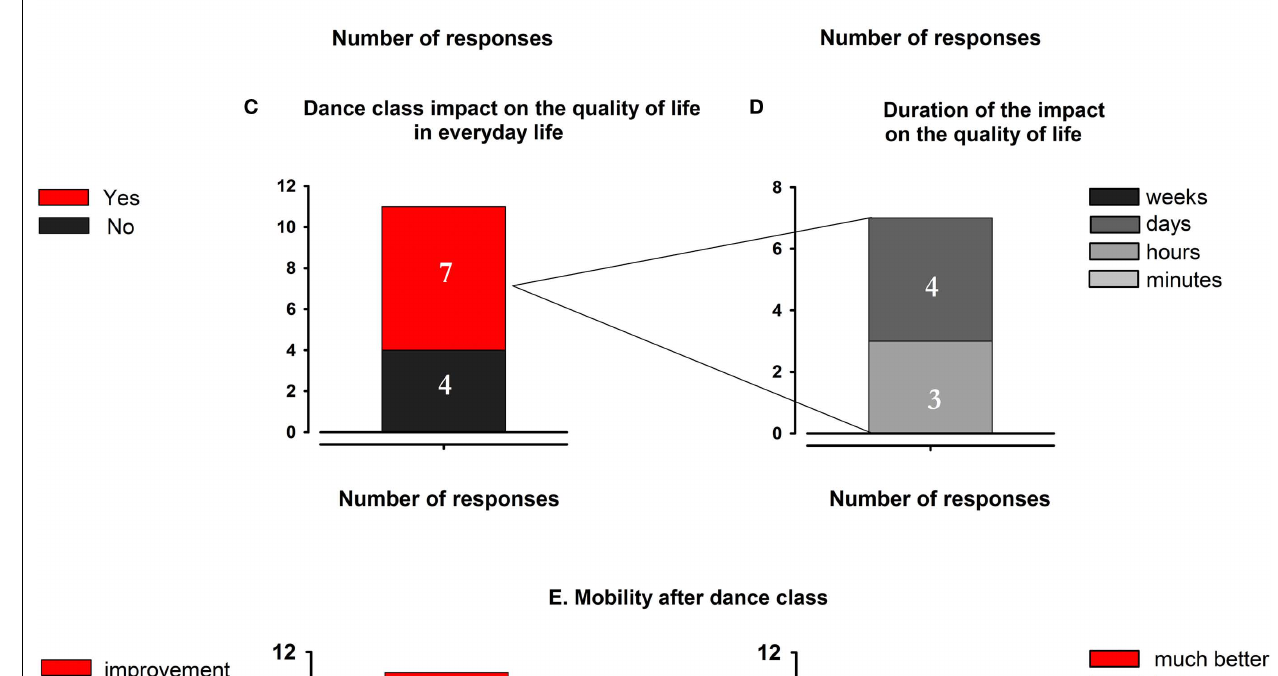
(C) Dance class impact on the quality of life in everyday life. (D) Duration of the impact on the quality of life. (E) Mobility after dance class.